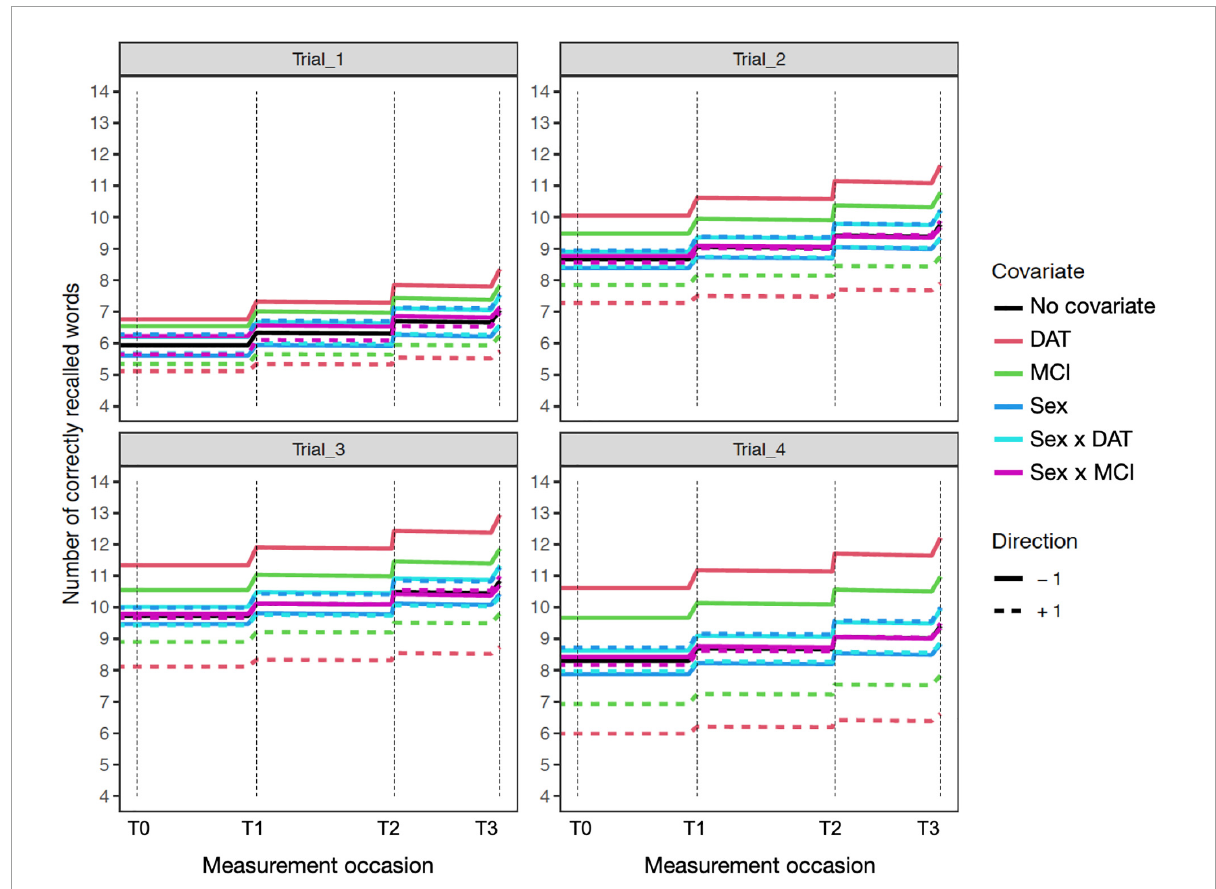
FIGURE4 Expectation plots for change in recall performance (black line) across four measurement occasions (e.g., T0: baseline, T1: 1 year) in the sensitivity model of participant age. The solid and dashed colored lines depict effect modification by time independent predictors: DAT diagnosis (red lines), MCI diagnosis (green lines), Sex (blue lines; women: +1; men: –1), and interactions of Age × DAT and Age × MCI. For covariate effects, higher (dashed) and lower (solid) levels of the covariate are shown to modify the level and expected slope. All covariate effects are in reference to 0 values of other